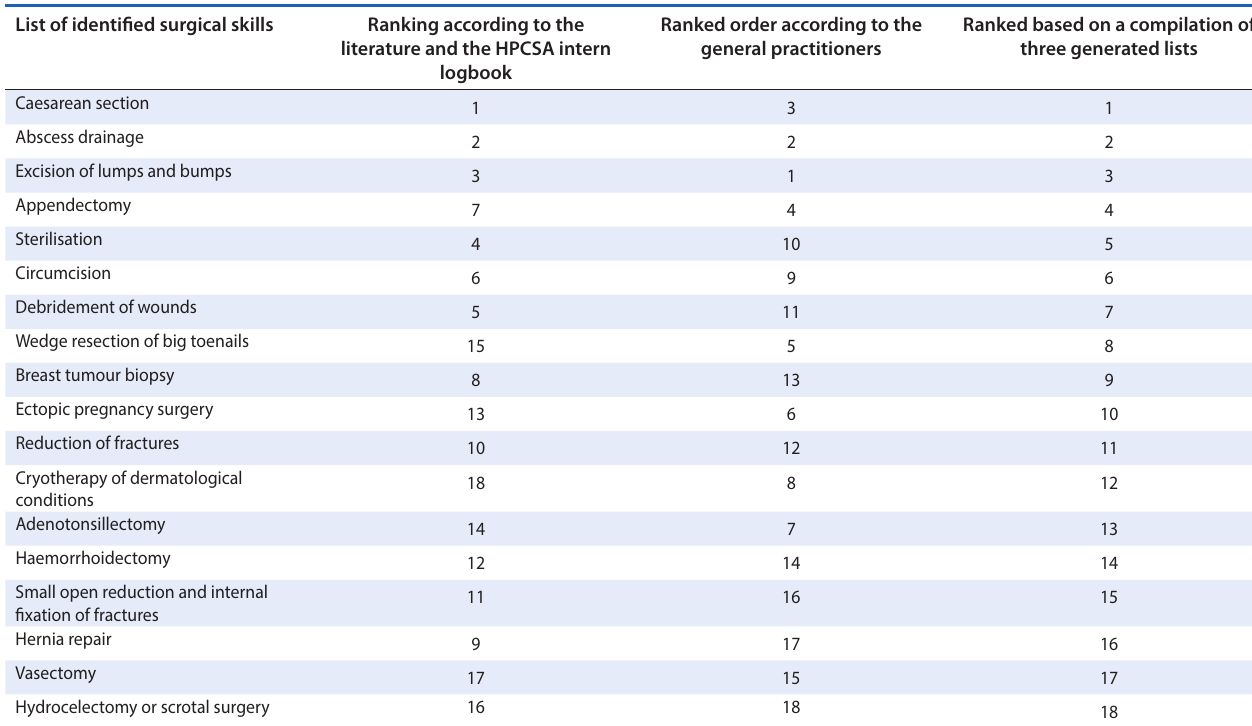
Table 1: Ranking of the core skills List of identified surgical skills